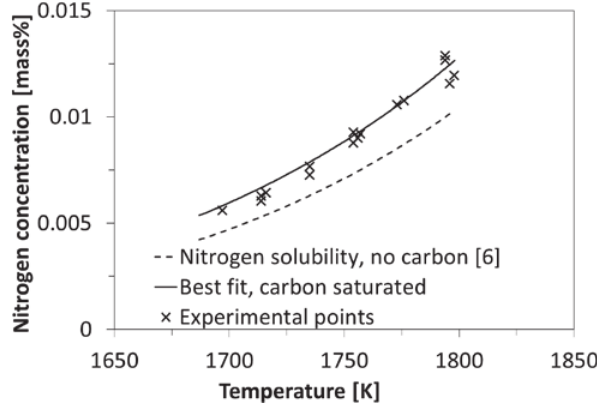
Fig. 2: The best fit equations for the solubility of nitrogen in liquid silicon. The dashed curve indicates the solubility limit in the pure Si–N-system [6], while the solid curve and the experimenntal points indicate the solubility in the carbon-saturated Si–C–N-system.